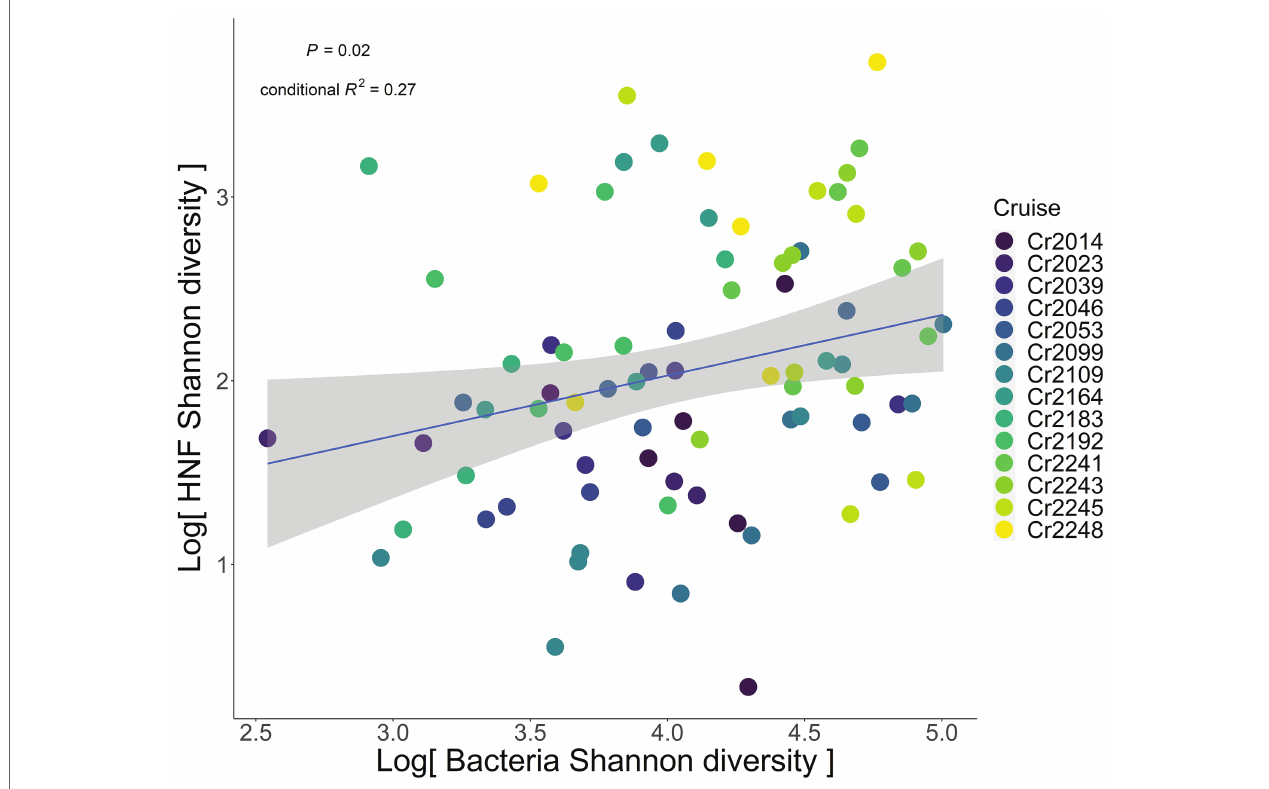
FIGURE 2 | Relationship between heterotrophic nanoflagellate (predator) and bacteria (prey) Shannon diversity. Blue solid line indicates the significant regression line fitted by the GLMM, with cruise as the random effect. Gray shaded area represents the 95% confidence interval of the regression line. The colors of dots represent different sampling